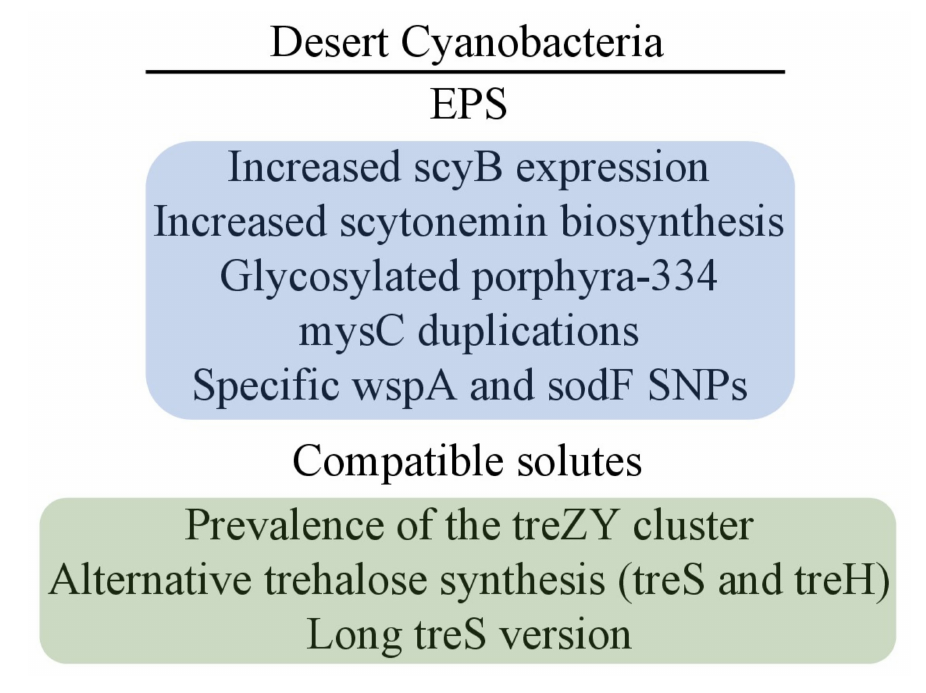
Figure 3. The main EPS and compatible solute features that distinguish desiccation-tolerant cyanobac- teria from desiccation-sensitive